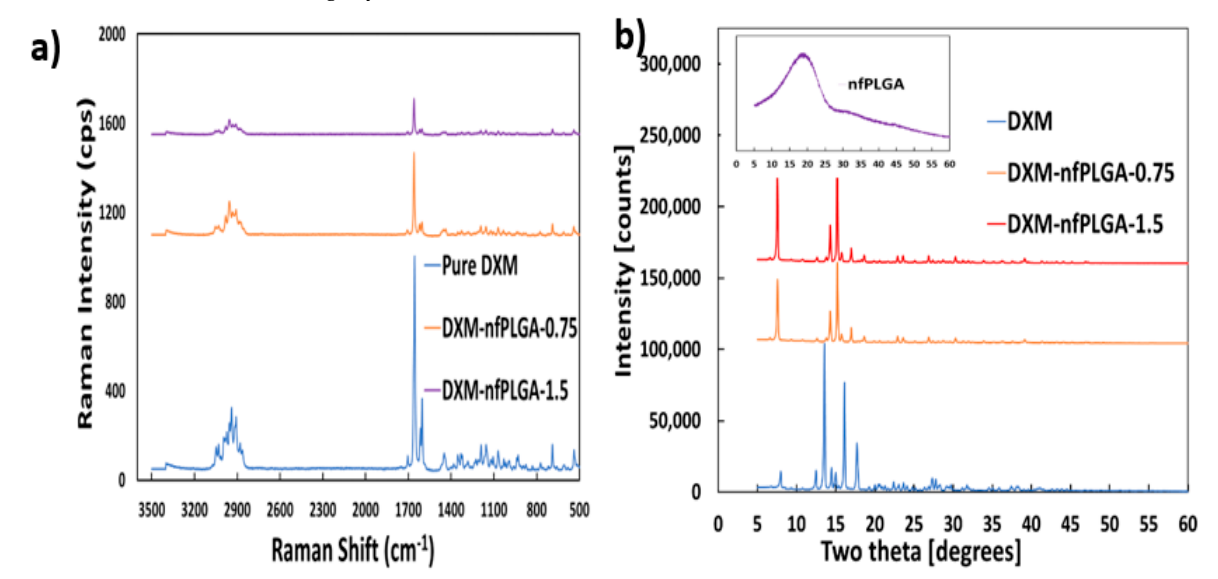
Figure 5: (a) DXM– nf PLGA composites RAMAN and (b) DXM– nf PLGA composites XRD analysis.